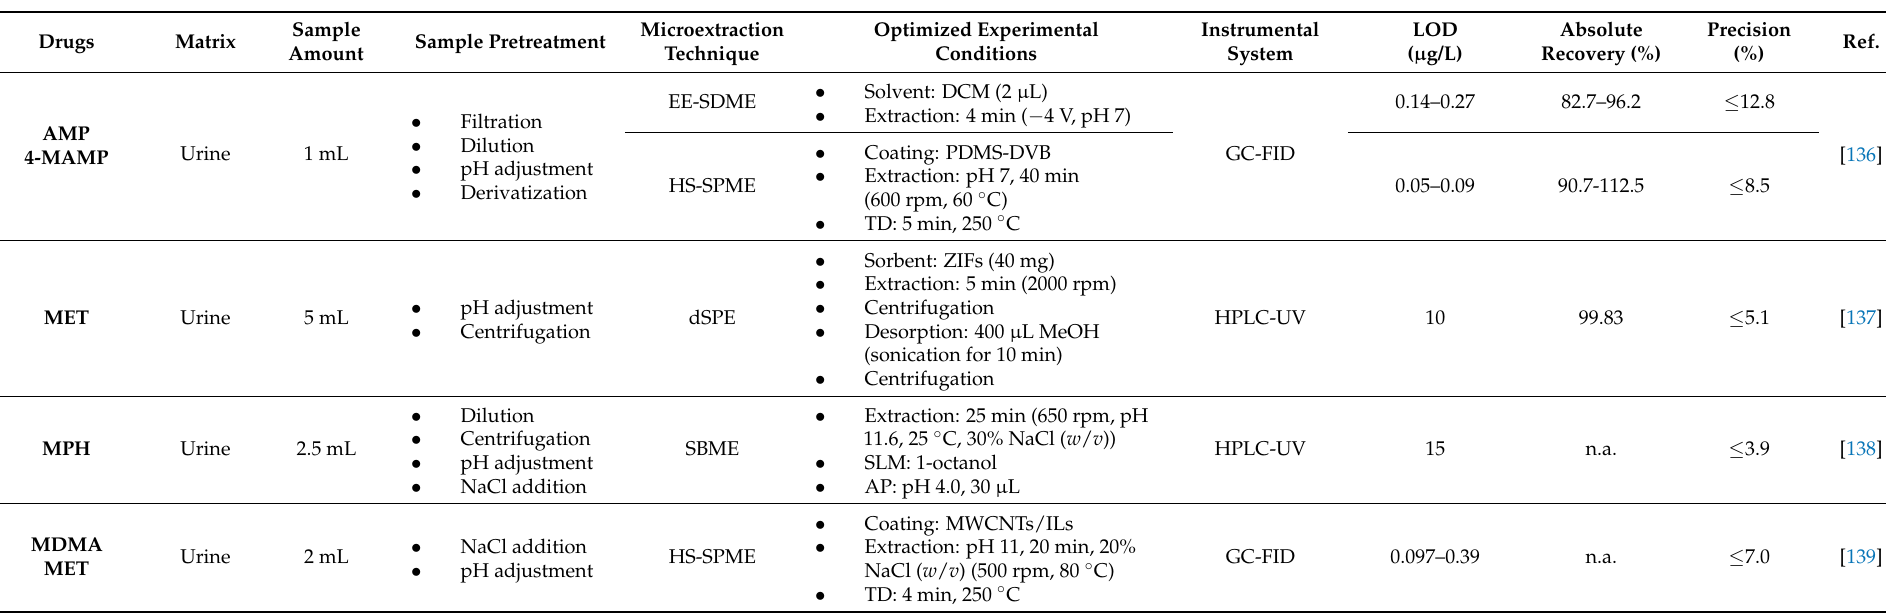
Table 3. Microextraction-based approaches for the analysis of amphetamine and related substances in the forensic